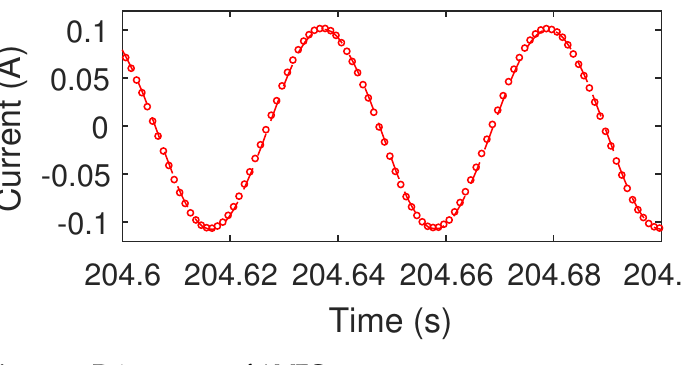
Figure 32. Drive current of AMFC.